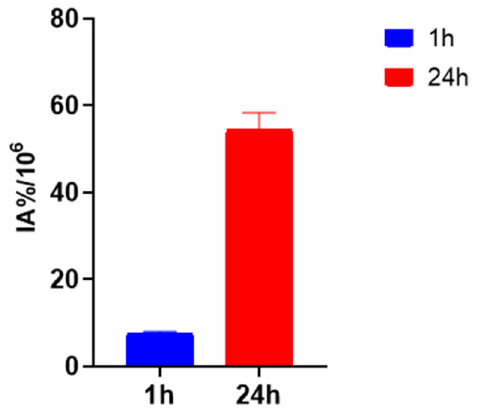
Figure 9. 22Rv1 internalization of 125 I-PSMA-7 at 1 h and 24 h.